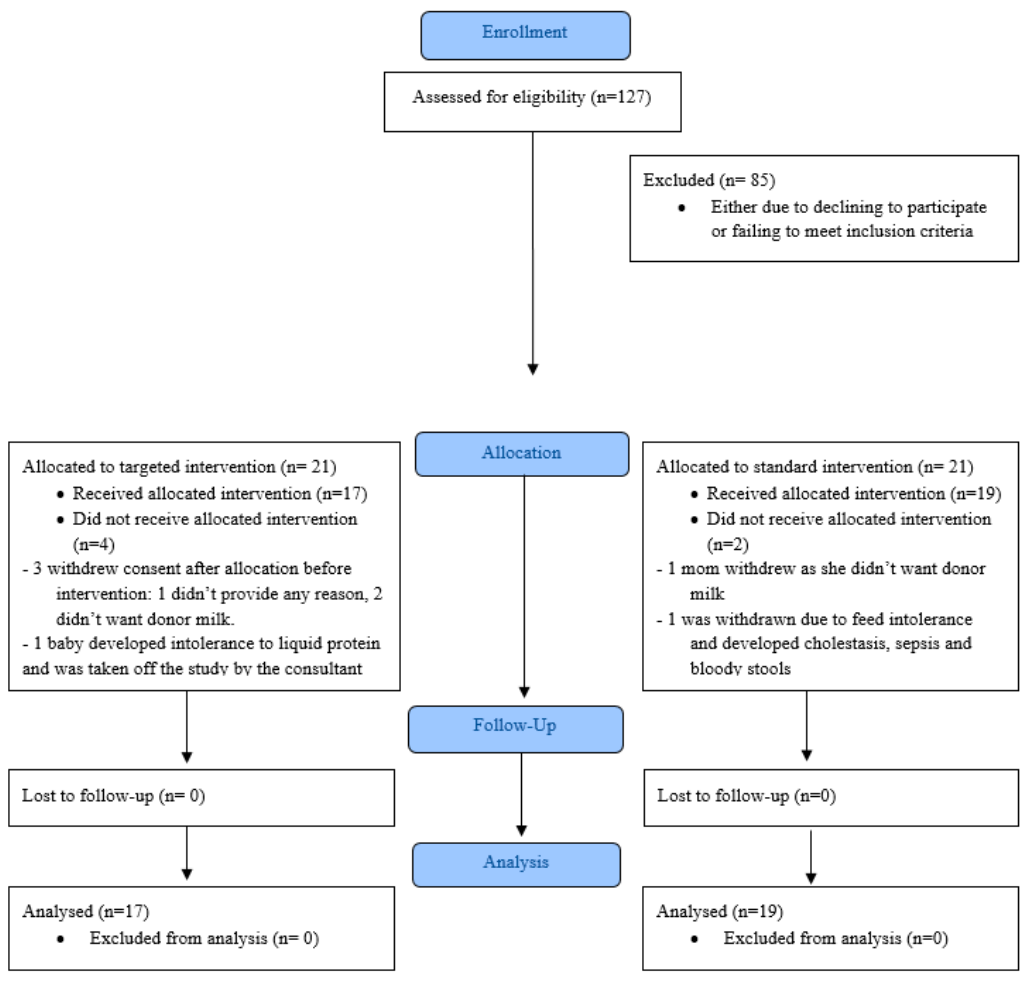
Figure 1. Flowchart of enrollment and participation.